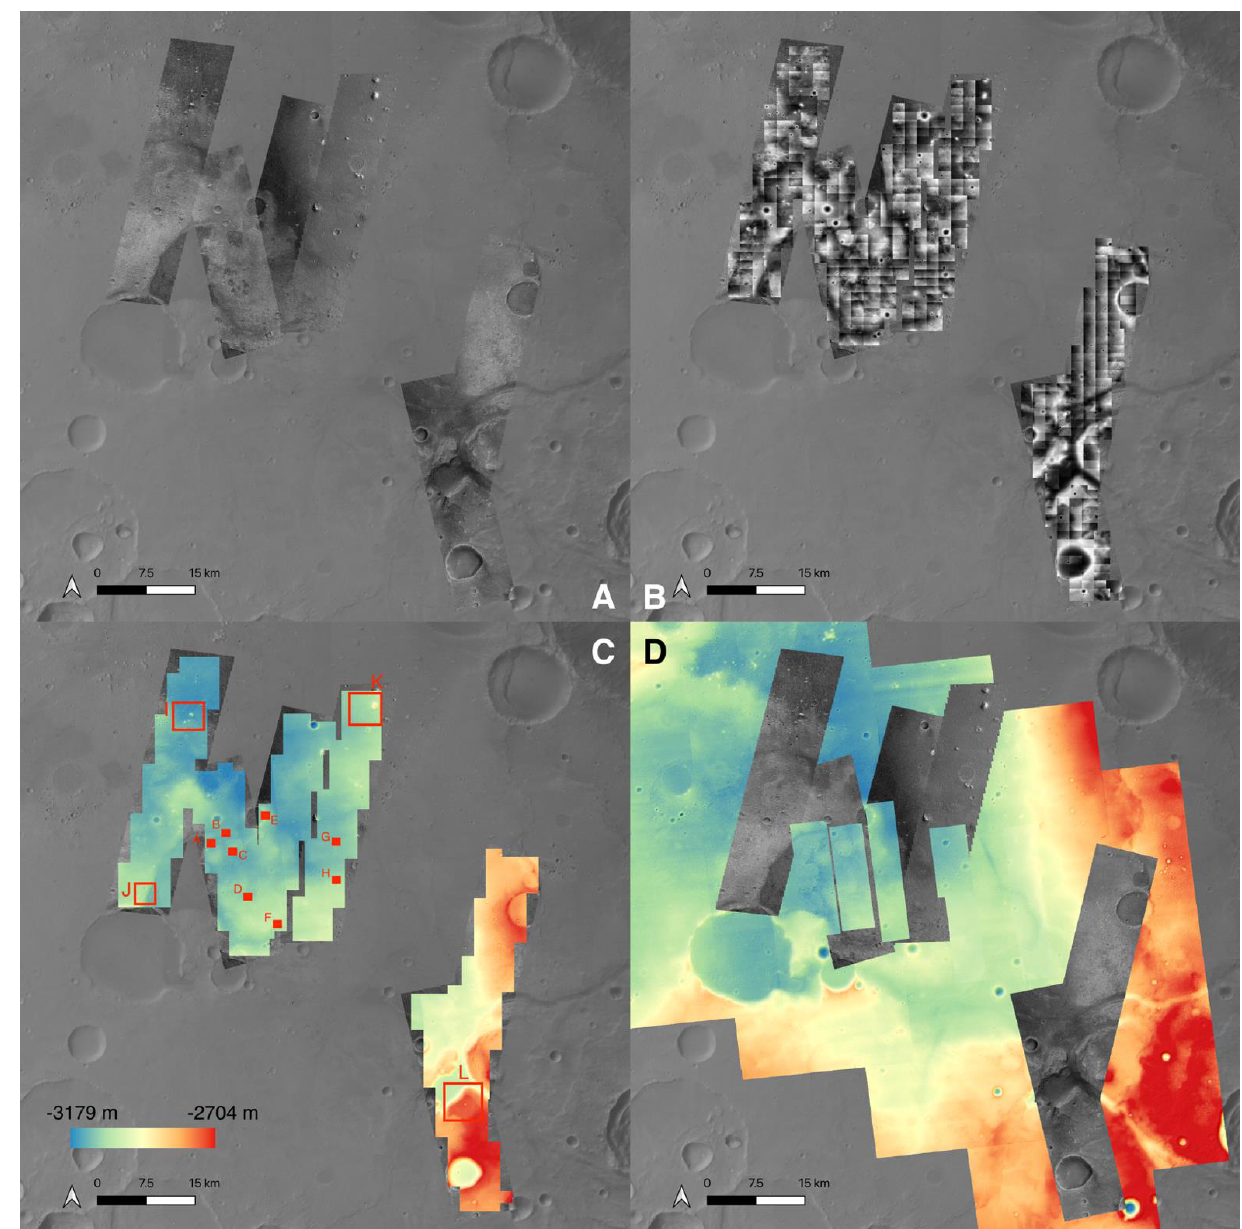
Figure 5. Overview of the testing and validation datasets at Oxia Planum: ( A ) input 6 CaSSIS images superimposed on HRSC ORI; ( B ) tiled CaSSIS DTM prediction outputs in relative height (black–0–low elevation; white–1–high elevation), superimposed on CaSSIS image and HRSC ORI; ( C ) final CaSSIS DTM outputs (colour hill-shaded) in absolute height co-aligned with HRSC, superimposed on CaSSIS image and HRSC ORI; ( D ) available validation dataset, i.e., HiRISE PDS DTM (colour hill-shaded) superimposed on CaSSIS image and CTX DTM mosaic (colour hill-shaded), superimposed on the HRSC ORI mosaic. Colour key for ( C , D ) is showing in ( C ). The locations for the zoom-in views and profile measurements shown in Section 3.2 are labelled as red squares in ( C ).